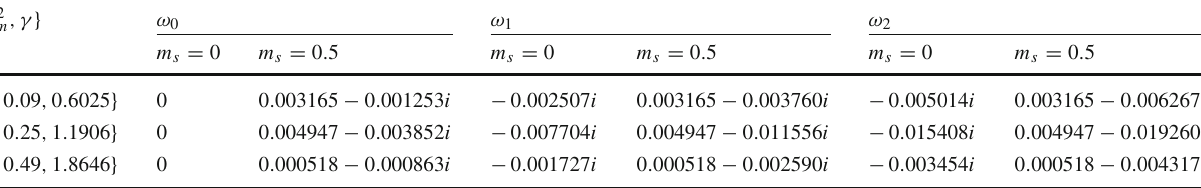
Table 1 The QNMs of dRGT black strings with α 2 m < 0 in the near extremal limit from formula (36). For demonstration purpose, we set M = 1 ,α